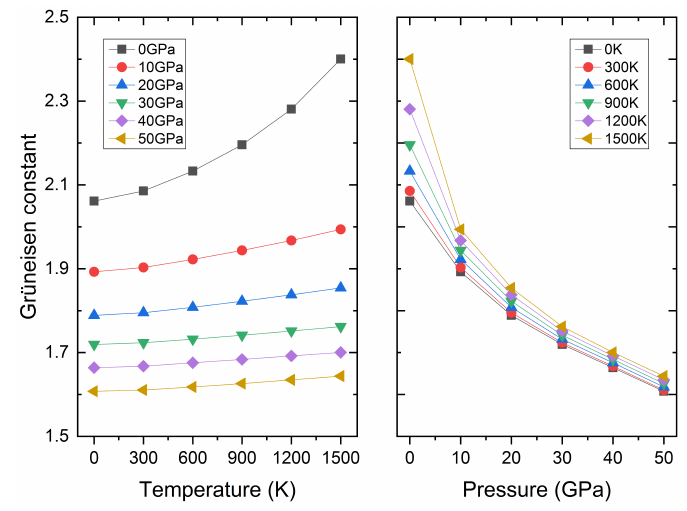
Figure 12. The Grüneisen constant γ variation with temperature ( left ) and pressure ( right ) for Ti 2 NiIn.